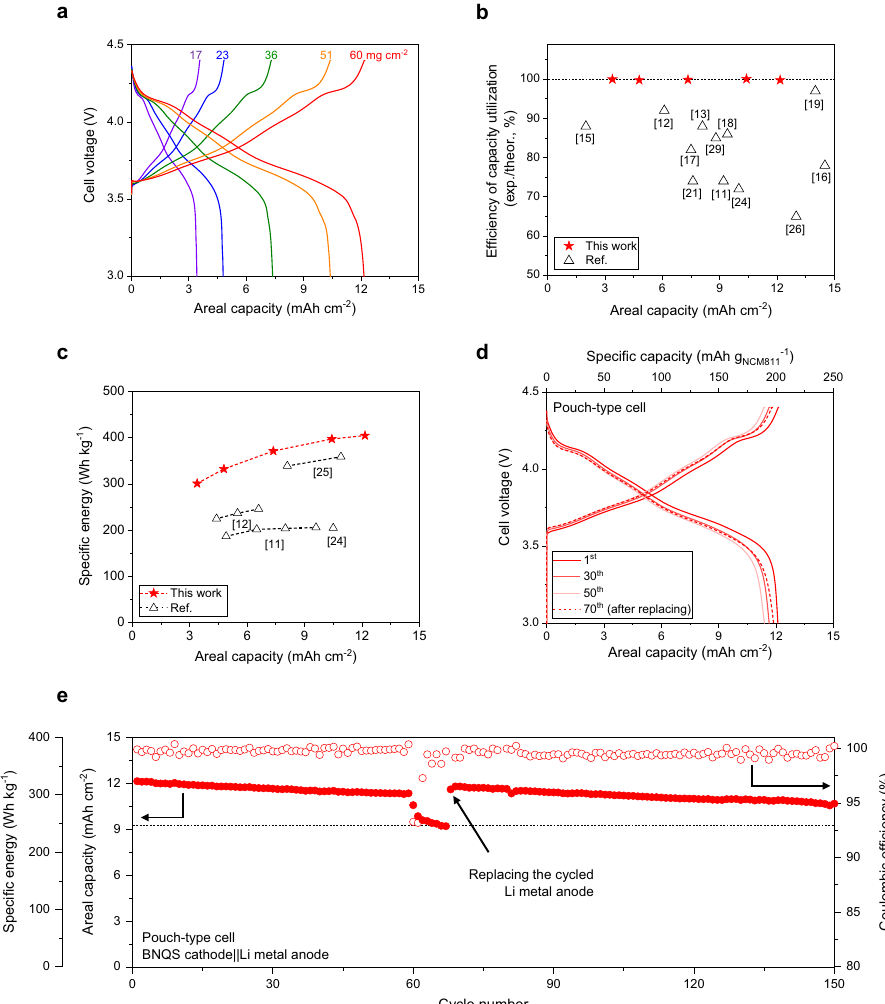
Fig. 6 Testing of Li metal cells with high-mass-loading cathodes. a Charge/discharge pro fi les of the coin cells (BNQS cathode || Li metal anode (100 μ m corresponding to an areal capacity of 20 mAh cm − 2 )) as a function of areal-mass-loading of the BNQS cathodes at a voltage range of 3.0 – 4.4 V